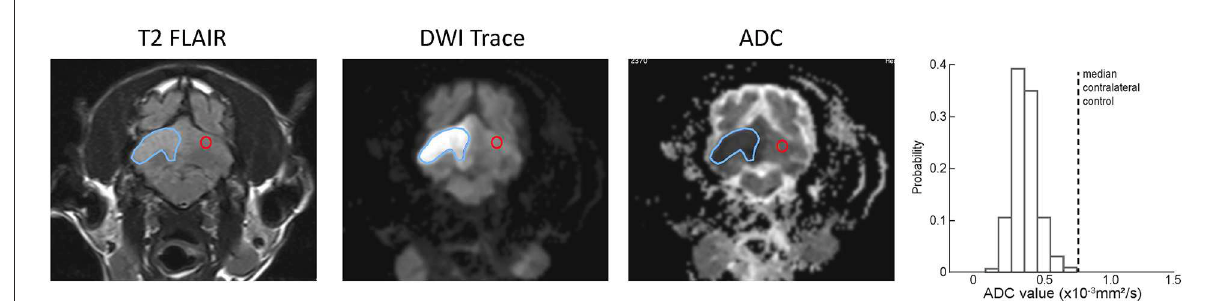
FIGURE2 Examples of ROI (blue outline) and contralateral normal control (red outline) region selection for a single slice from representative example ischemic CVA. A region was selected for every slice on the T2-FLAIR transverse images and copied to the corresponding slice for the DWI and ADC series. The histogram at the right shows the ADC values within the ROI, as well as the median ADC value within the contralateral control region (dotted line).